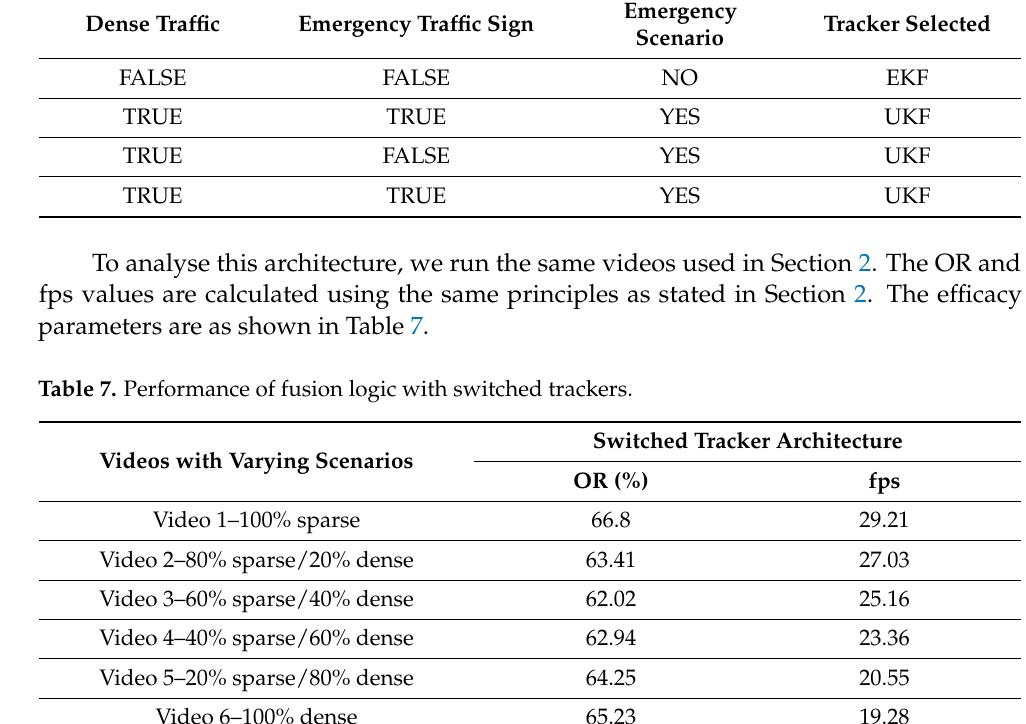
Figure 19. Image taken at t = 13.03 s. Traffic state: Dense. Tracker—UKF.